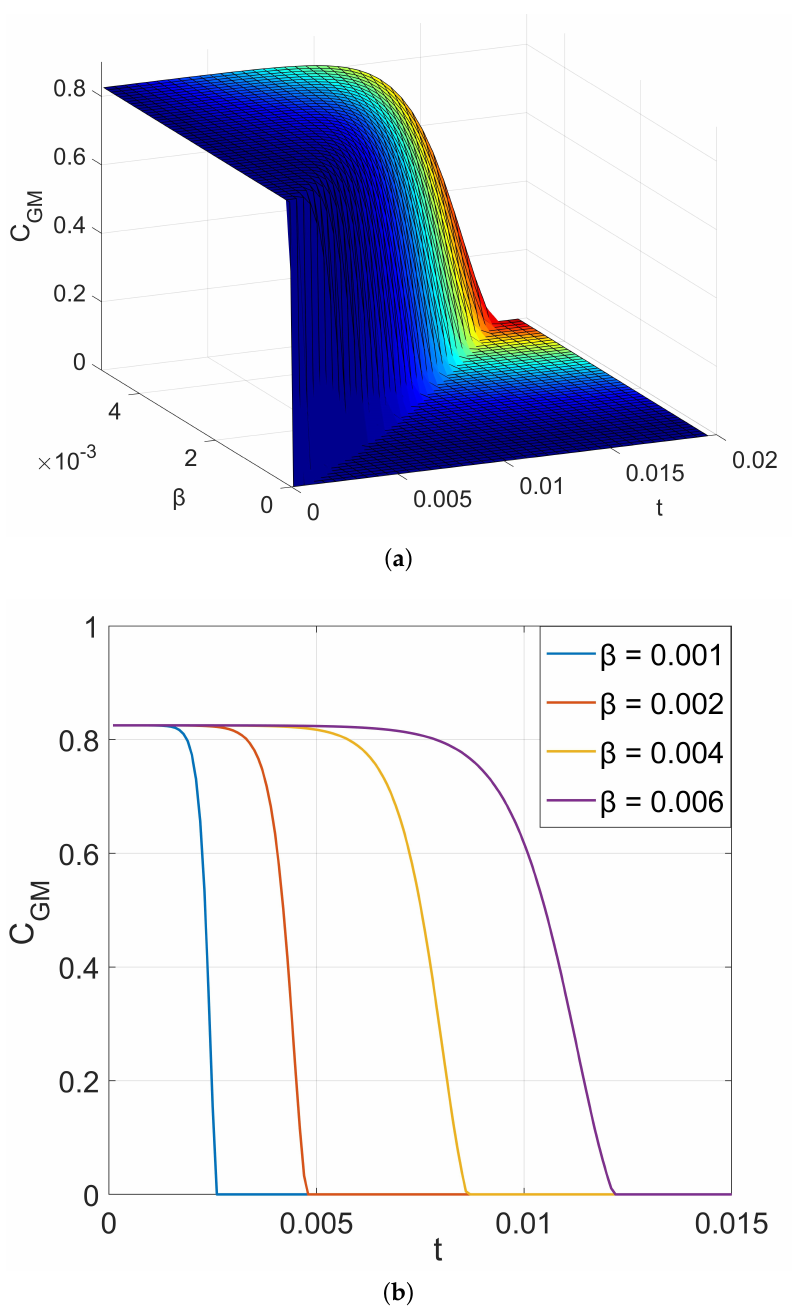
Figure 3. ( a , b ) Genuine multipartite concurrence with inverse temperature, and time (in seconds) for ohmic reservoir at a fixed mixing parameter x = 0.9 and ω 0 = 1. As the temperature increases, the state experiences the sudden death of correlation